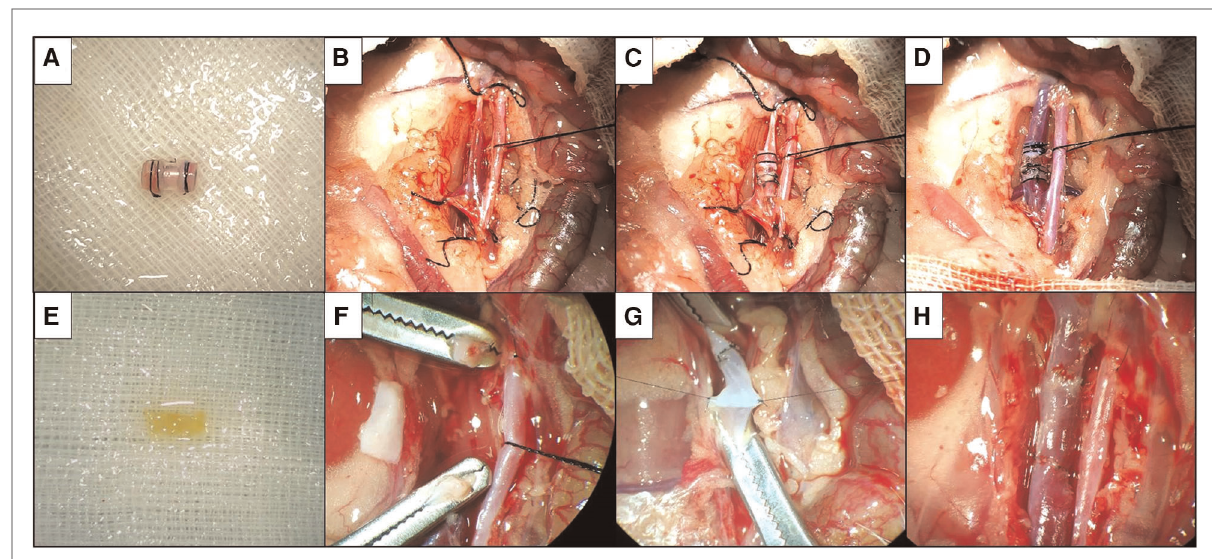
FIGURE 1 Two kinds of vein replacement model. ( A ) Donor venous cuff by cuff method. ( B ) Silk suture blocks distal and proximal veins. ( C ) Donor venous cuff is implanted after about 2/3 of the circumference of anterior wall of recipient vein is cut. ( D ) Silk suture fi xes venous cuff to open venous blood fl ow. ( E ) Suture method of donor venous segment. ( F ) Dissection after vascular clamp blocks distal and proximal veins. ( G ) Continuous suture after suspension of venous wall. ( H ) After the completion of suture, open venous blood fl